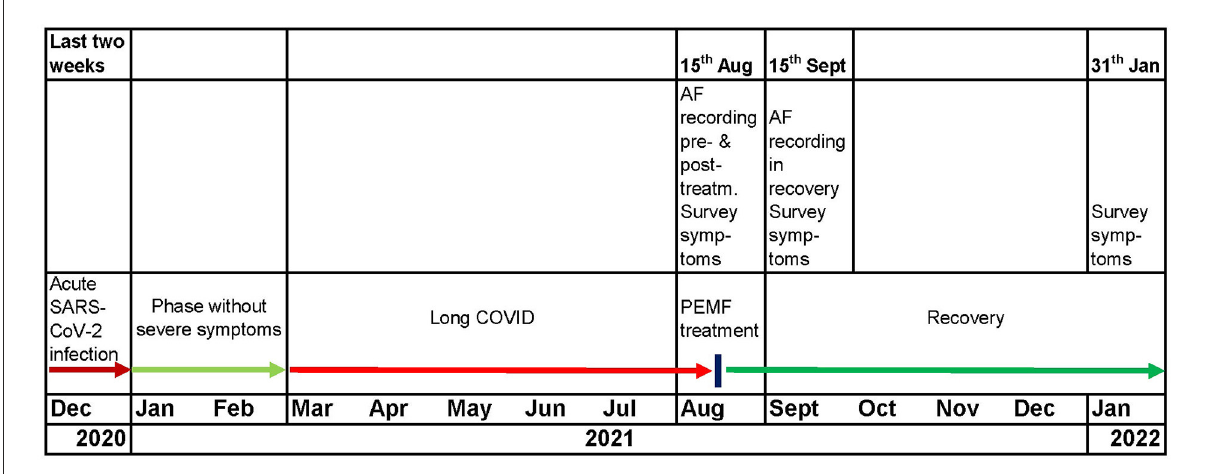
FIGURE3 Timeline from acute SARS-CoV-infection over the ∼ 6-month Long COVID period until the individualized PEMF treatment resulting into sustained recovery ( ∼ 6-month post-treatment).